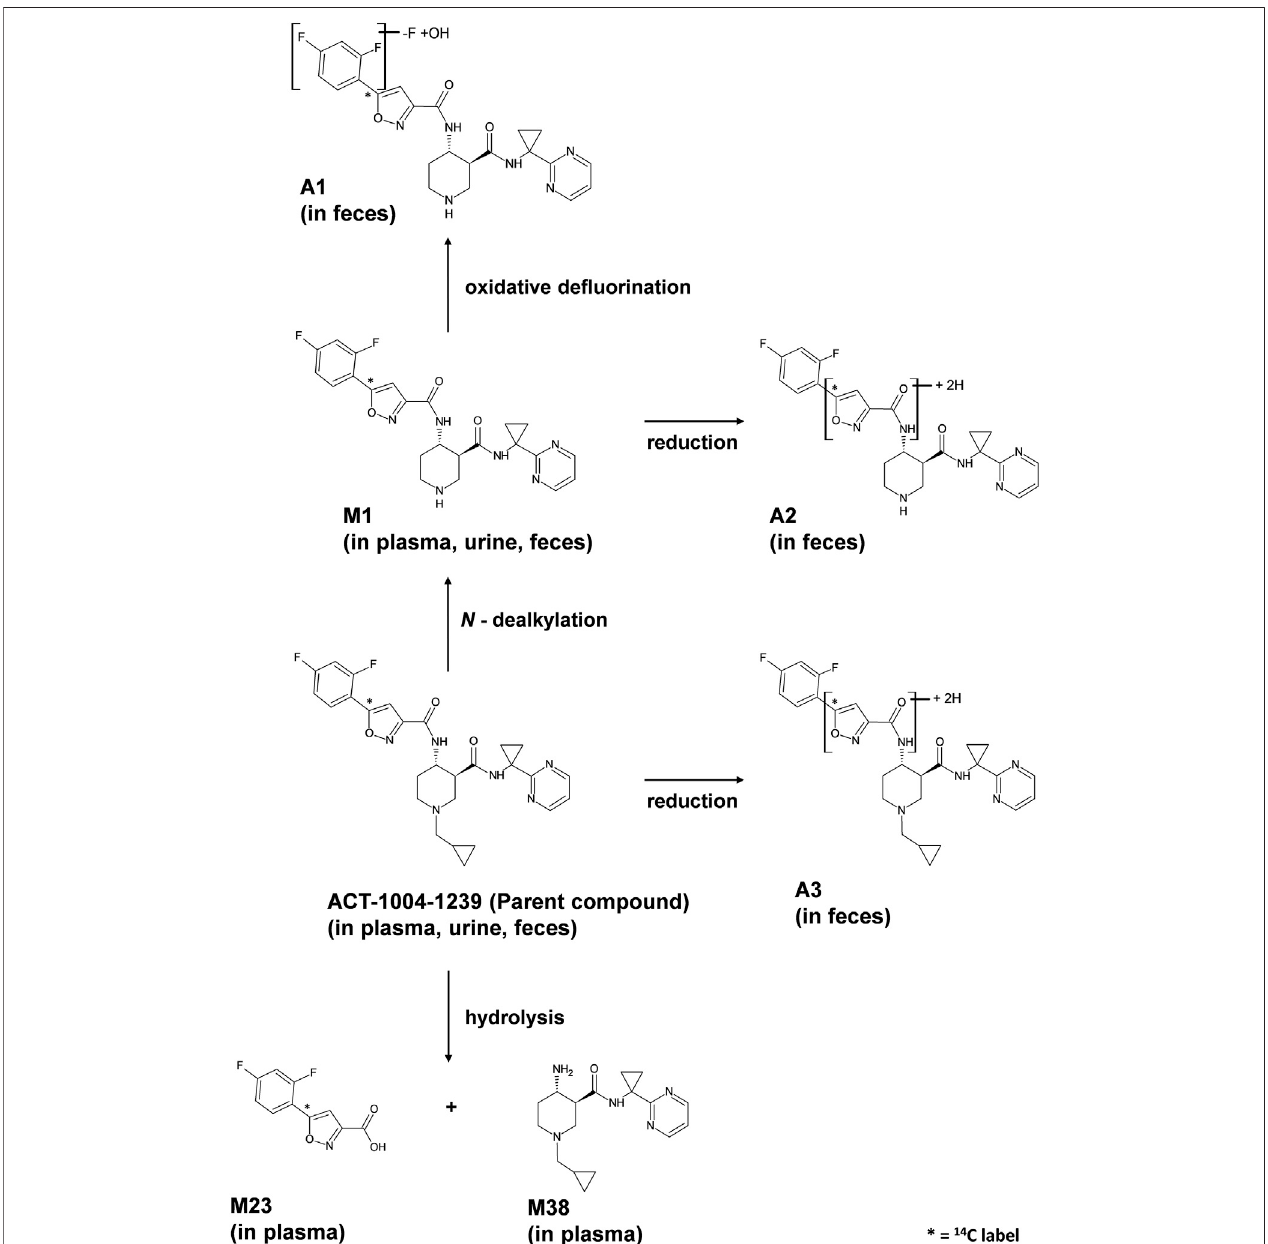
FIGURE 7 | Proposed metabolic pathways of ACT-1004-1239 in